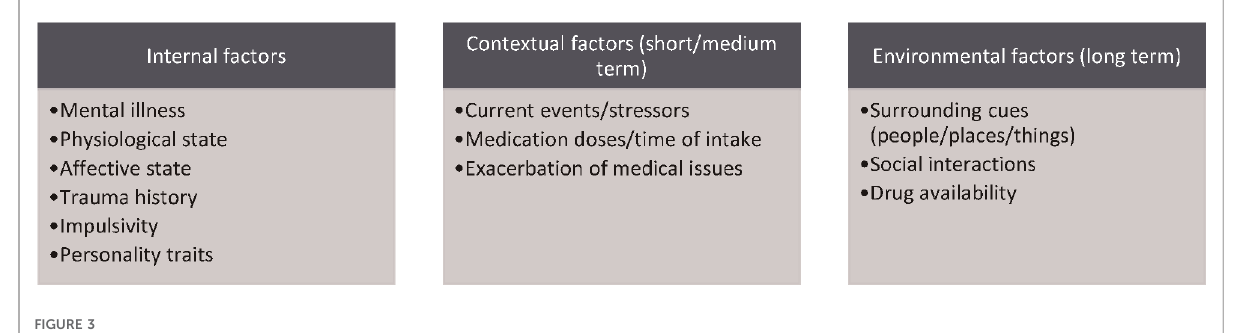
FIGURE 3 Factors potentially contributing to cravings and measurable by wearable